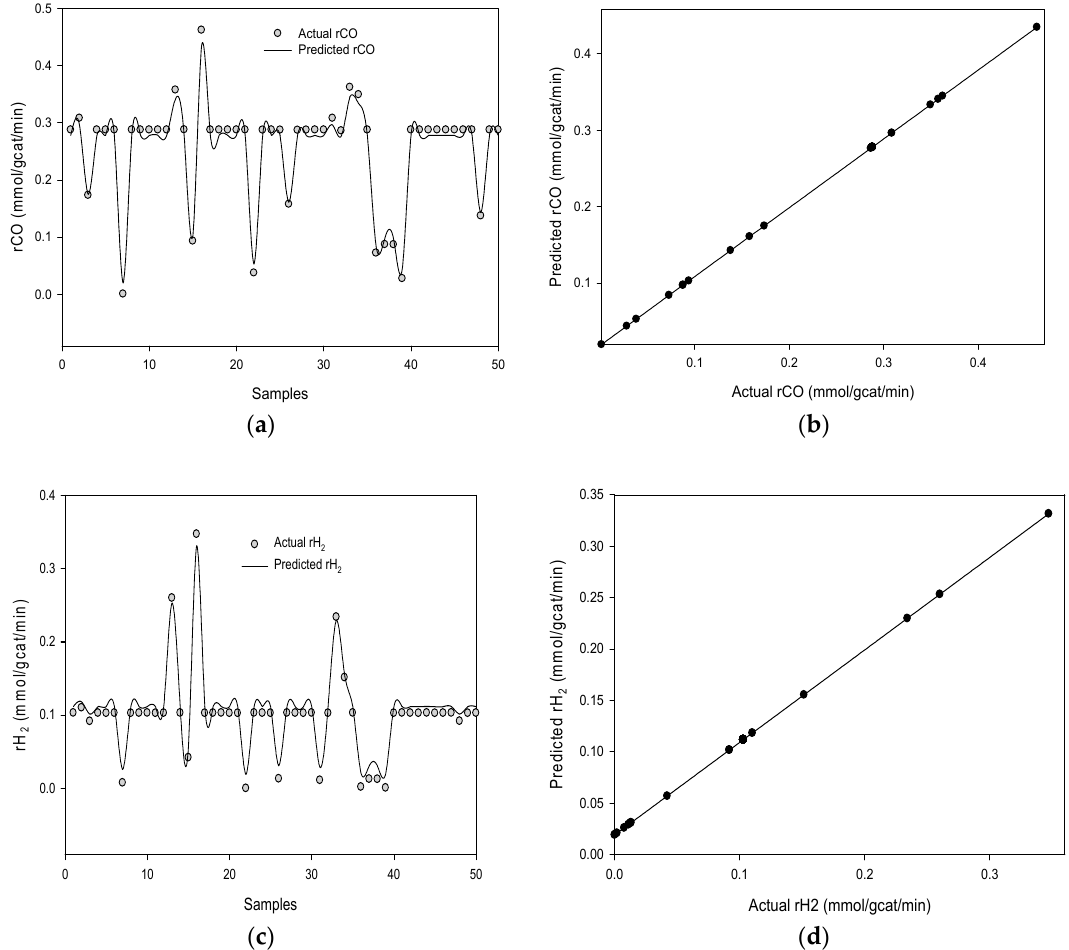
Figure 8. ( a ) Dispersion plot showing the comparison between actual and predicted rCO; ( b ) Parity plots showing the comparison between actual and predicted rCO; ( c ) Dispersion plot showing the comparison between actual and predicted rH 2 ; ( d ) Parity plots the comparison between actual and predicted rH 2 using scaled conjugate gradient algorithm.